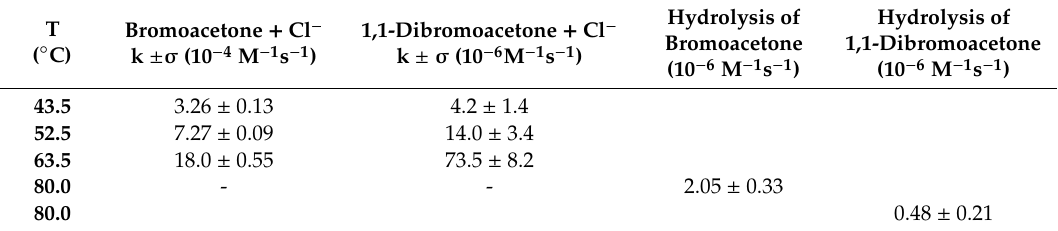
Rate constants for nucleophilic exchange reactions with chloride and hydrolysis of bromoacetone and